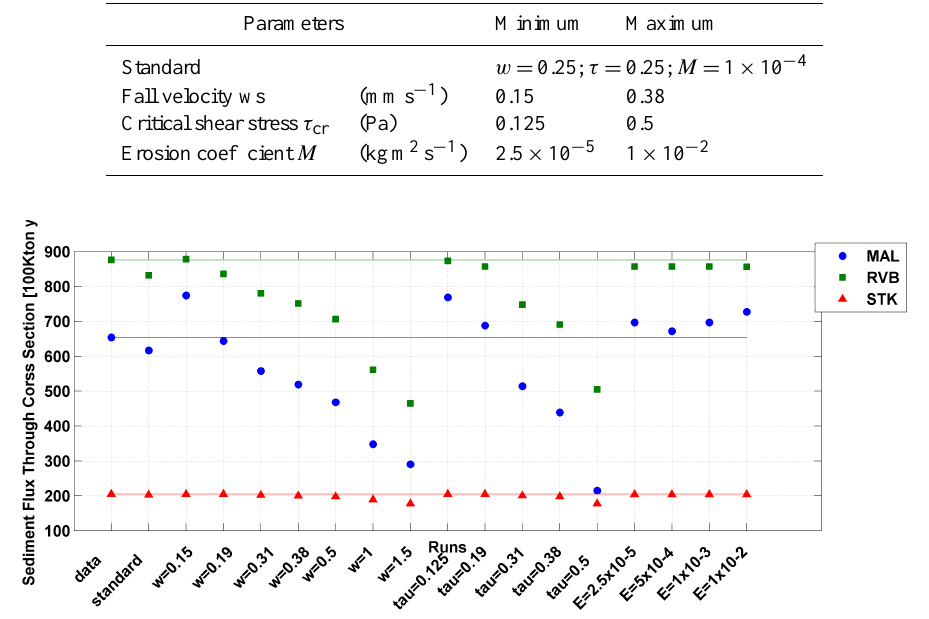
Figure 5. Sensitivity analysis for sediment flux at RVB on the Sacramento River (green squares), at STK on the San Joaquin River (red triangles) and at MAL where the Delta meets the Bay (blue circles). The colored lines indicate the data values.